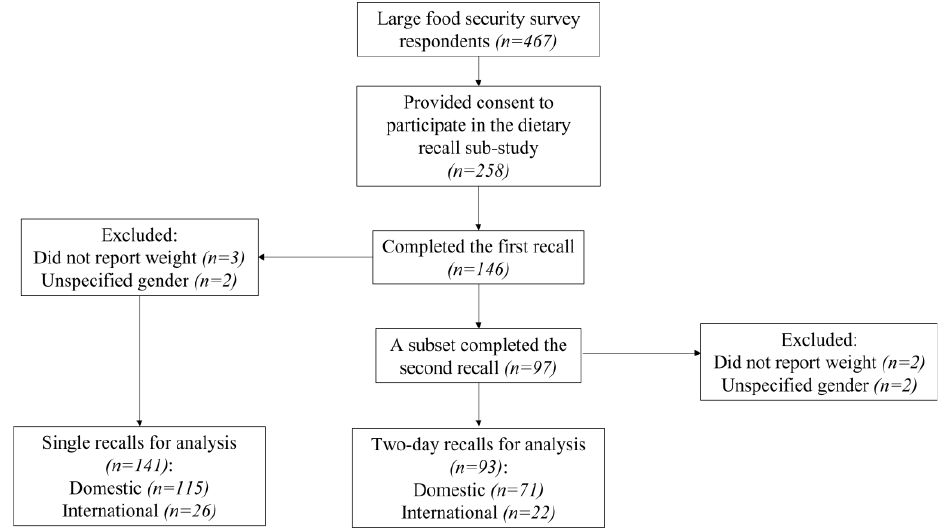
Figure 1. Flow diagram describing sample size.